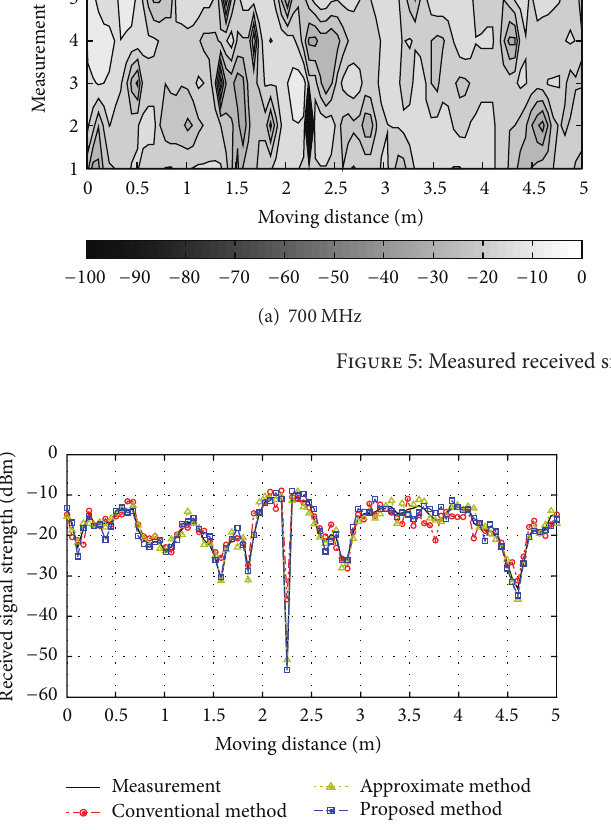
Figure 7: Comparison of fading effect along path 2 for measured and simulated results at 7